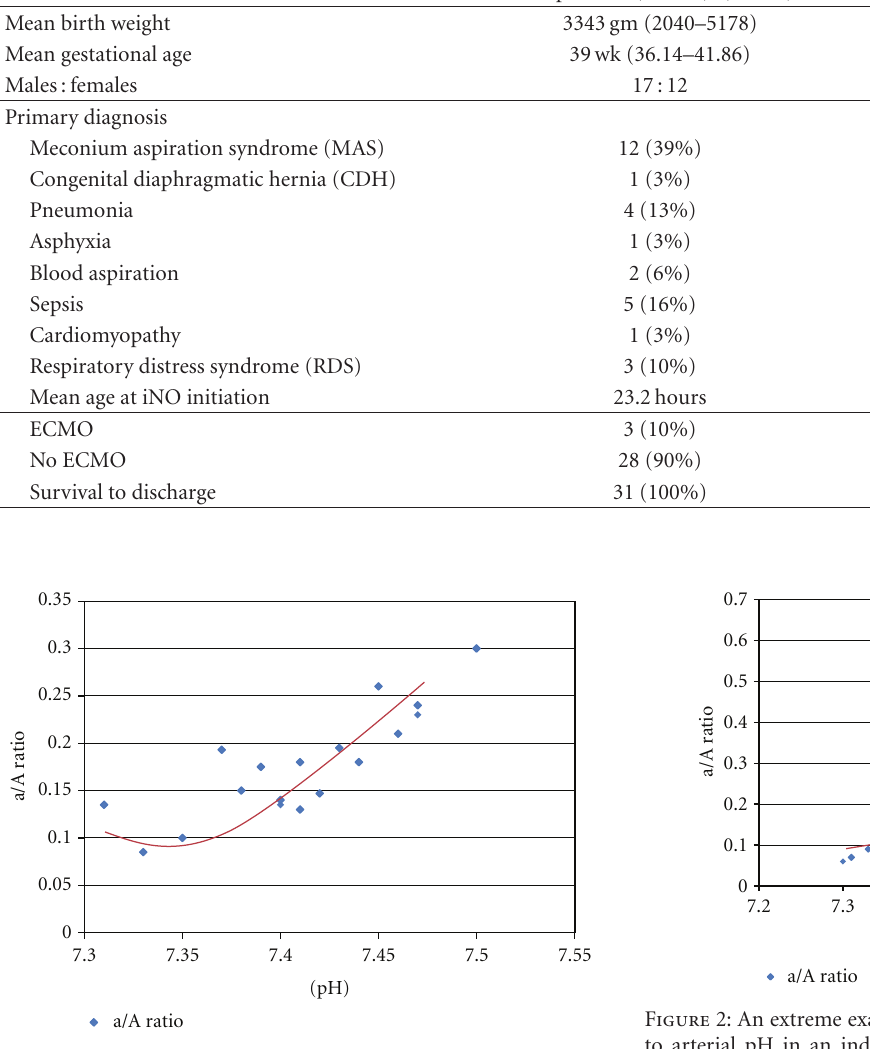
Figure 1: Linear response of a/A ratio to arterial pH in an individual patient. Correlation coe ffi cient = 0.836, P < 0 . 01.